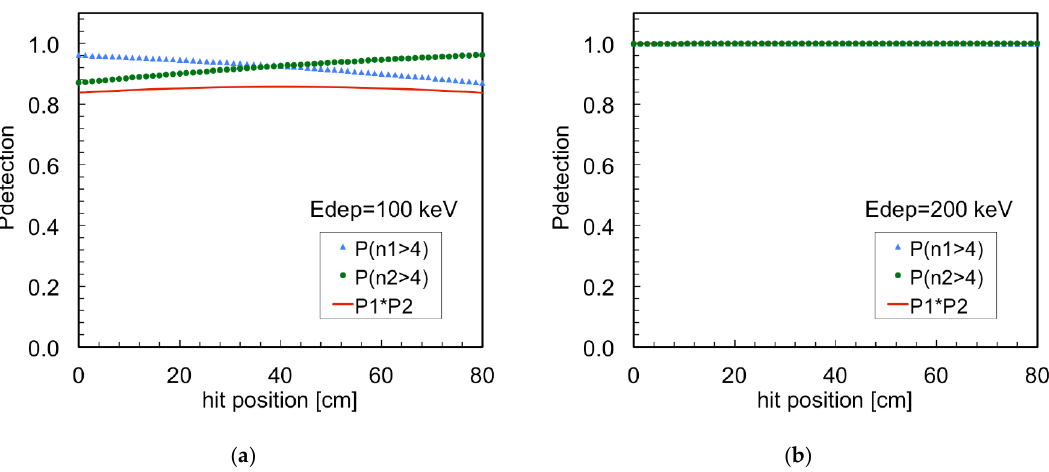
Figure 6. Detection efficiency of a gamma-ray as a function of the impact position on a 120 cm long fiber, calculated as the product of the probabilities of getting at least four photons detected on each SiPM. ( a ) When the gamma-ray deposits 100 keV . ( b ) When the gamma-ray deposits 200 keV.